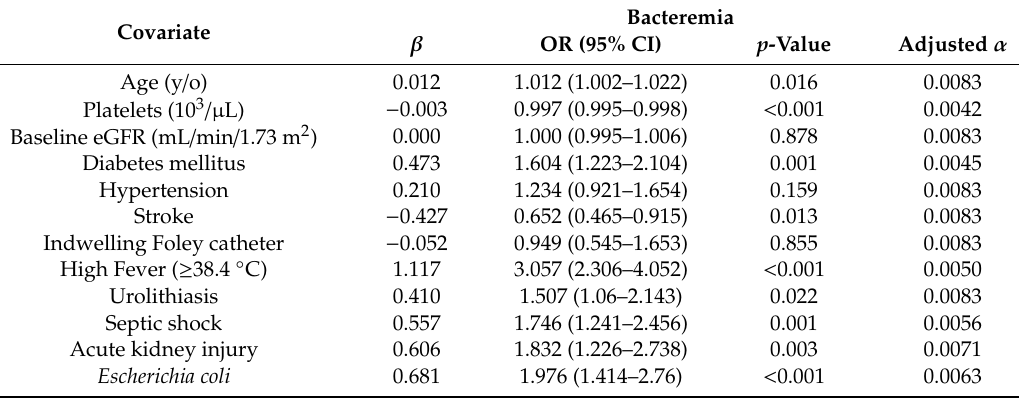
Table 5. Multivariate logistic regression analyses of factors related to bacteremia in patients with urinary tract